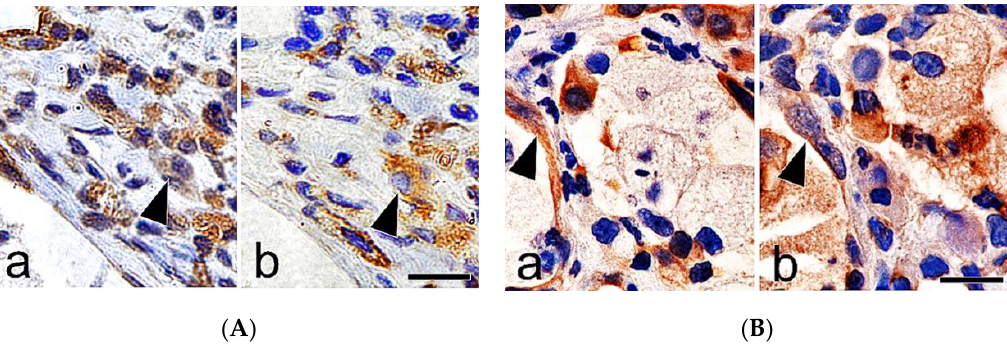
Figure 8. ( A ) Immunohistochemistry of the serial sections of the lung tissues at 12 months after silica treatment, showing cytokeratin ( a : a black arrow head) and vimentin ( b : a black arrow head) positive labelling in hyperplastic epithelial cells in the fibrotic lesions. Bar = 15 μm , and ( B ) immunohistochemistry of the serial sections of the lung tissues at 12 months after silica treatment, showing cytokeratin ( a : a black arrow head) and α -smooth muscle actin ( b : a black arrow head) positive labelling in spindle cells in the fibrotic lesions. Bar = 15 μm.